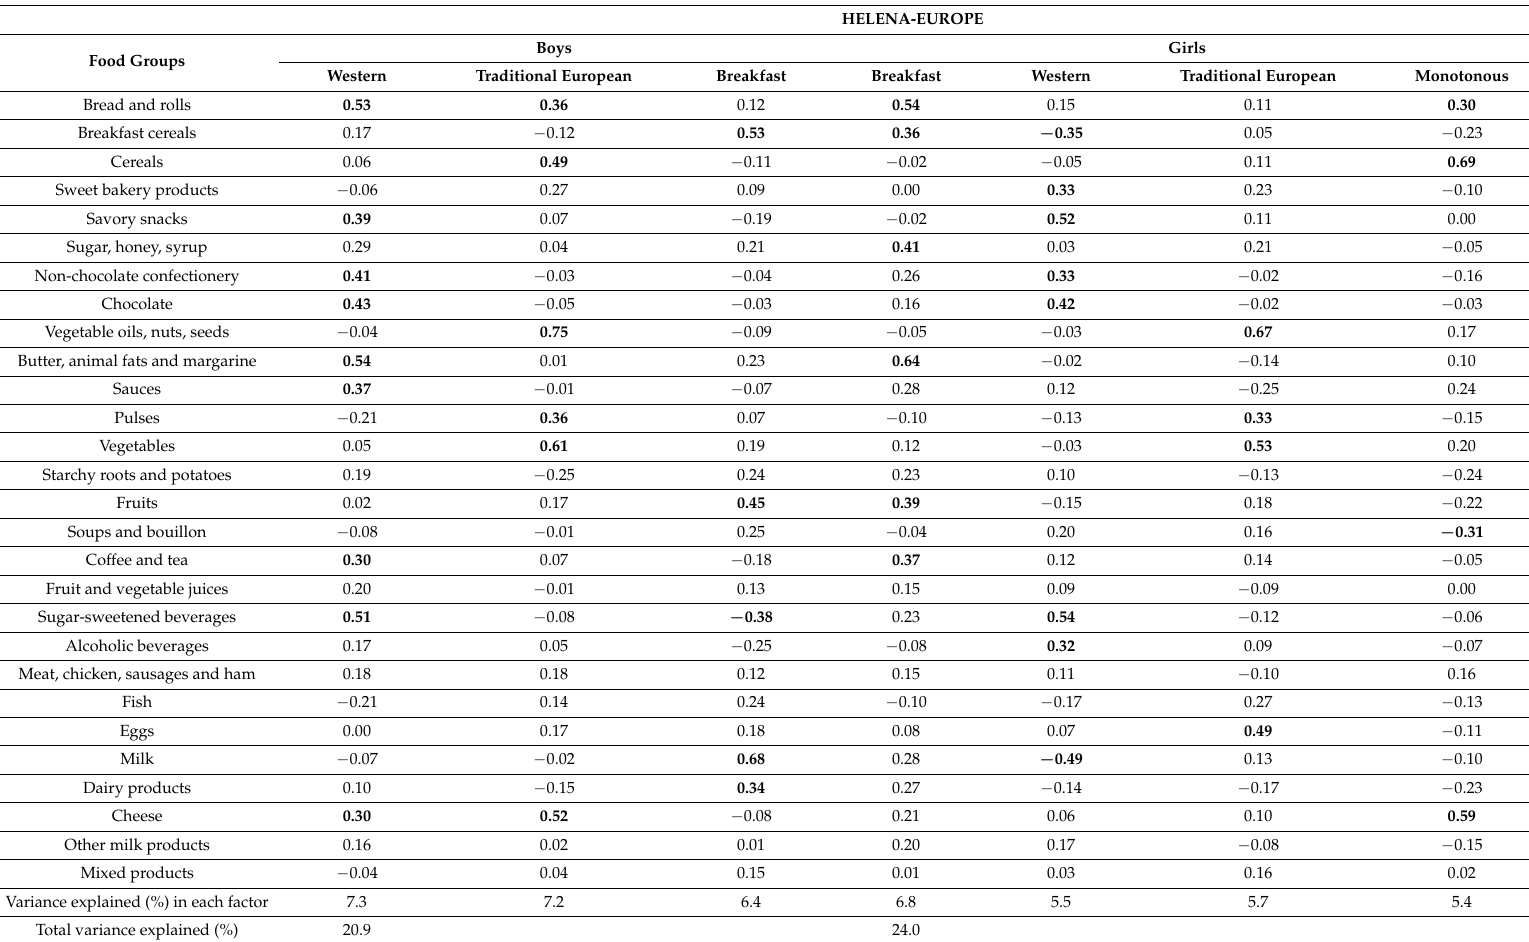
Table 2. Factor loadings of food groups present in the dietary patterns identified among adolescents from HELENA-Europe 2006/2007 study. HELENA-EUROPE Boys Girls Food Groups Western Traditional European Breakfast Breakfast Western Traditional European